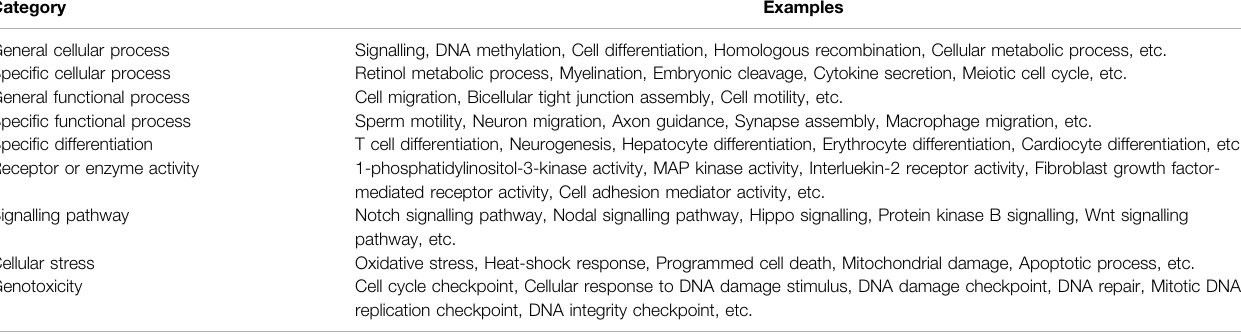
TABLE 2 | DARS identi fi ed molecular process categorised depending on the cellular